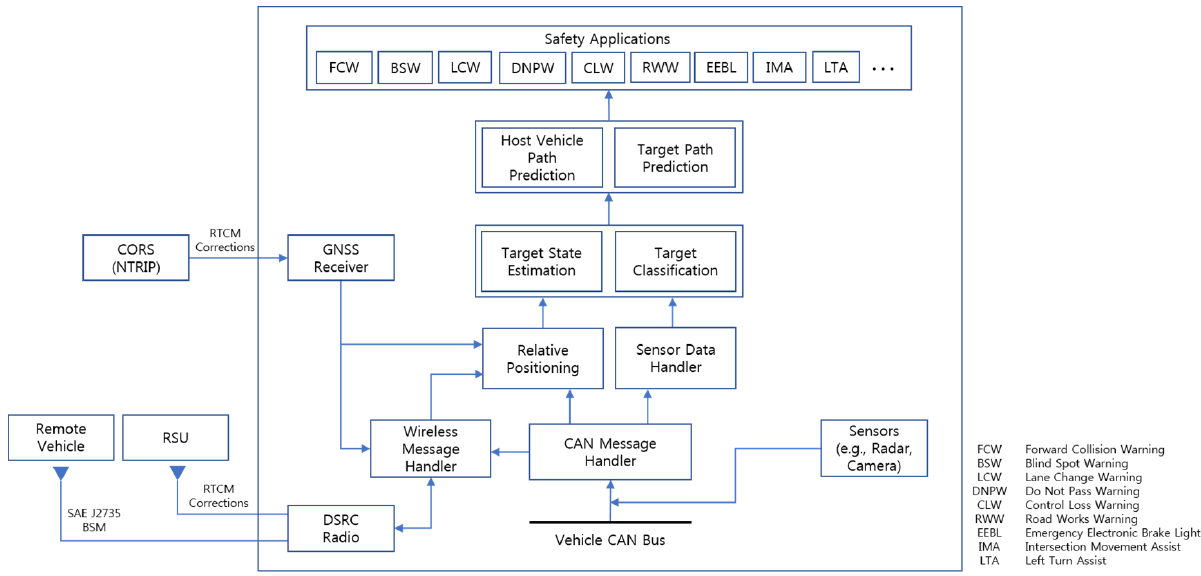
Figure 1. Functional blocks of the proposed cooperative environment perception system. For cooperative relative positioning, and particularly for the fusion of the on-board sensors and V2X communications, it is necessary to transform the GNSS positioning information (i.e., latitude and longitude) of the host vehicle and the remote targets from the World Geodetic System 1984 (WGS 84) reference frame to the host vehicle reference frame. For this, WGS-84 coordinates are converted to earth-centered, earth-fixed (ECEF) coordinates and then to east-north-up (ENU) coordinates. The GNSS course heading of the host vehicle is utilized to finally rotate the remote target positions and find their relative positions in the host vehicle reference frame. The relative positions and other dynamic information on remote targets acquired from V2X communications can be used in conjunction with the measurements from on-board sensors for more accurate and reliable target state estimation, classification, and trajectory prediction. Some of the